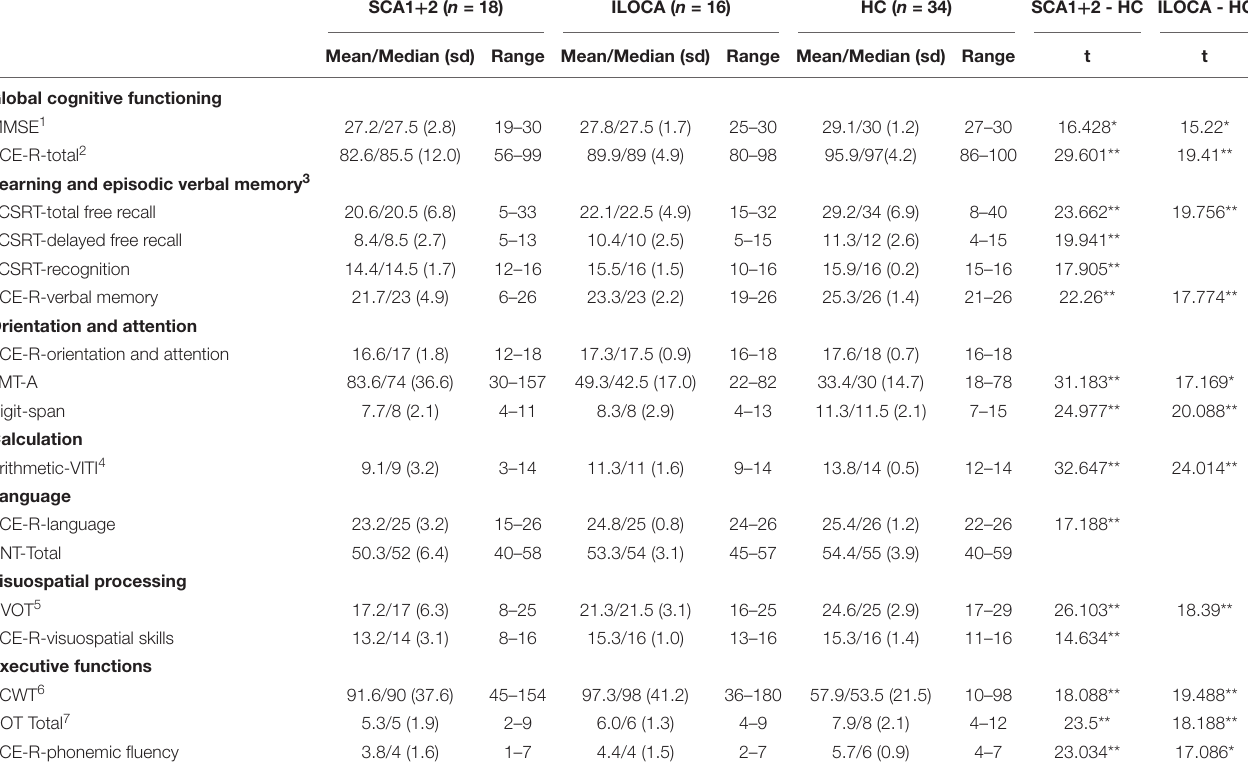
TABLE 2 | Neuropsychological screening – descriptive statistics and group